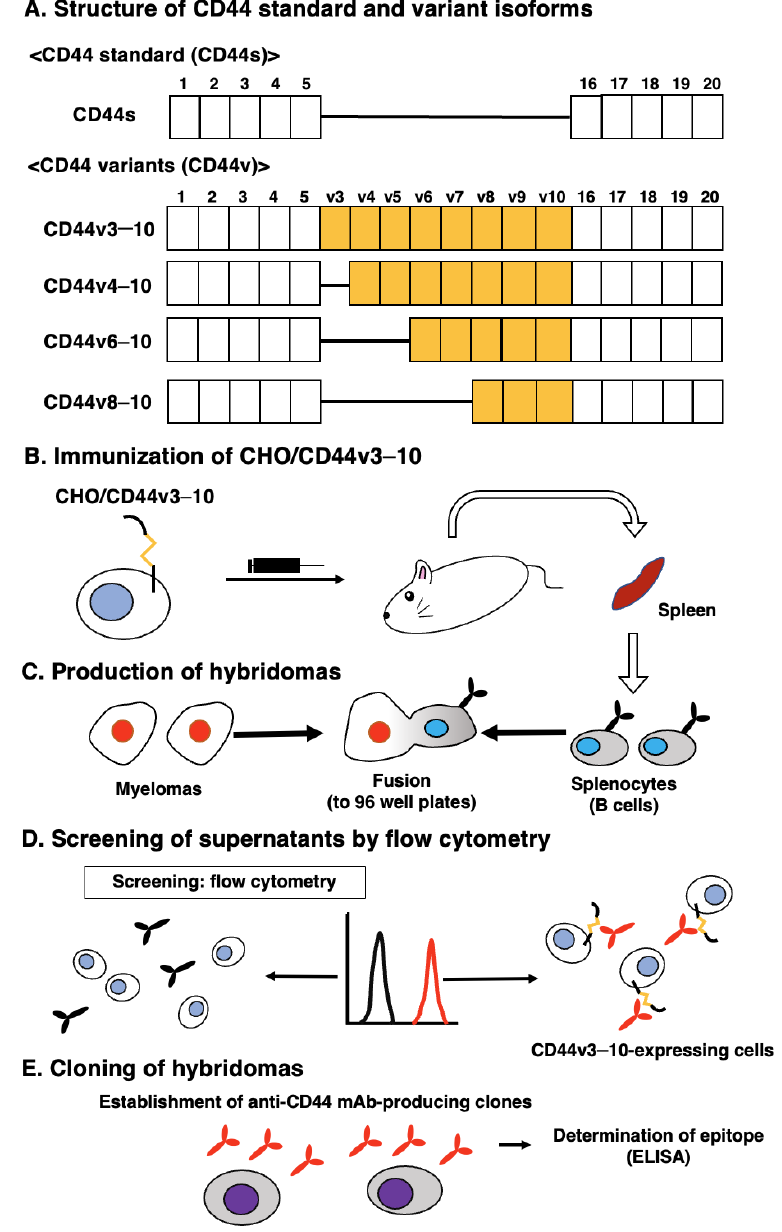
Figure 1. A schematic representation of anti-human CD44 mAbs production. ( A ) Structure of CD44. The CD44s mRNA is assembled by the first five (1 to 5) and the last five (16 to 20) exons and translates CD44s. The mRNAs of the CD44 variant are produced by the alternative splicing of middle variant exons and translate multiple CD44v such as CD44v3–10, CD44v4–10, CD44v6–10, and CD44v8–10. ( B ) CHO/CD44v3–10 cells were intraperitoneally injected into BALB/c mice. ( C ) Hybridomas were produced by fusion of the splenocytes and P3U1 cells. ( D ) The screening was performed by flow cytometry using CHO/CD44v3–10 and parental CHO-K1 cells. ( E ) After cloning and additional screening, a clone C 44 Mab-1 (IgG 1 , kappa) was established. Furthermore, we used peptides that cover the extracellular domain of CD44v3–10 (Supplementary Table S1) and determined the binding epitopes of each mAb using enzyme-linked immunosorbent assay